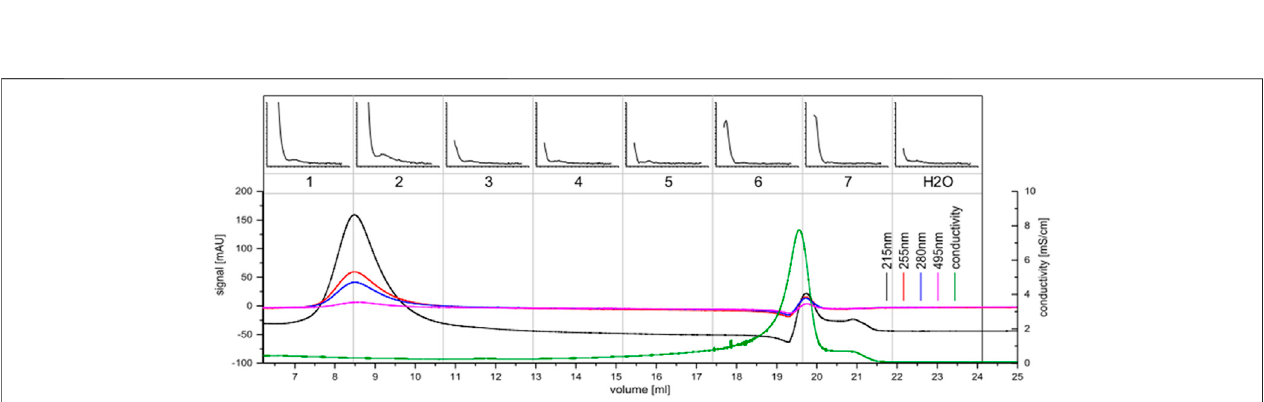
FIGURE 5 | Size exclusion chromatography of the concentrate of C. brevissima ; The UV-signal in mAU is plotted against the elution volume for the wavelengths 215 nm(black),255 nm(red),280 nm(blue)and495 nm(pink).Theconductivityisdisplayedingreen.2.5 mlfractionswerecollected(numbered1-7).Eachfractionwas measuredvialuminescencespectrometry.The Δ RFU-values(beforeandafteradditionofTb)measuredat545 nm(200 – 5000,ifnotnotedotherwise)areplottedagainst the excitation wavelength (230 – 402 nm). Also, the H 2 O-background measurement is displayed. Fractions one and two were pooled for further analysis.